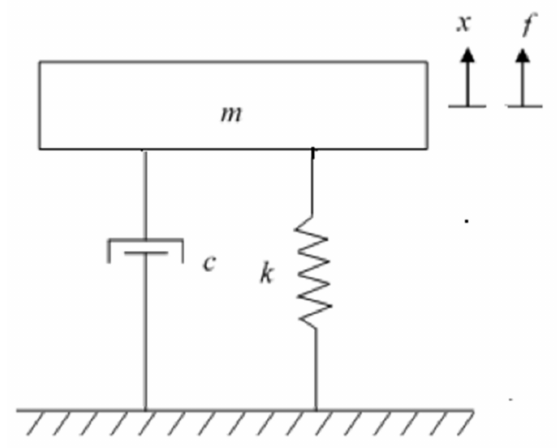
Figure 2. Schematic diagram of the motorcycle engine mount